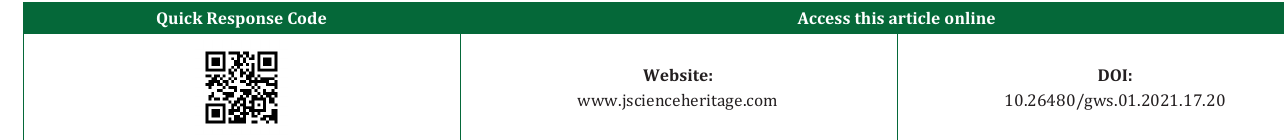
Figure 1: Agricultural production volumes vs. Food wastage volumes (FAO, 2011a) So, to combat this issue, sustainable development goal 12 (responsible consumption and production) has target to halve per capita global food waste at the retail and consumer levels and reduce food losses along production and supply chains, including post-harvest losses(UN,